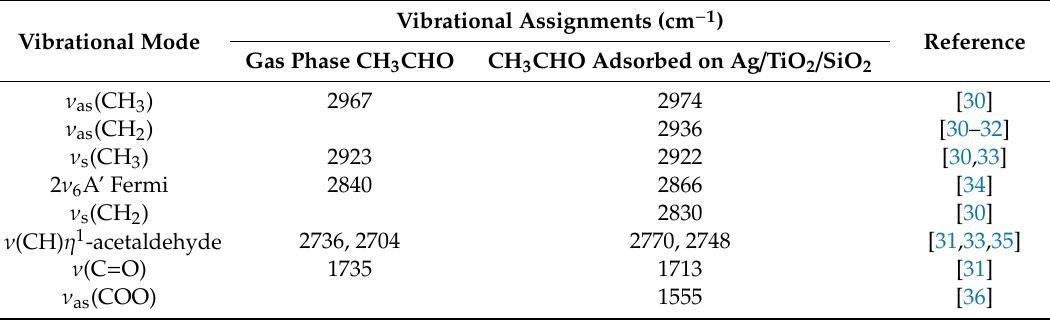
Table 2. Adsorbed acetaldehyde: observed bands and their